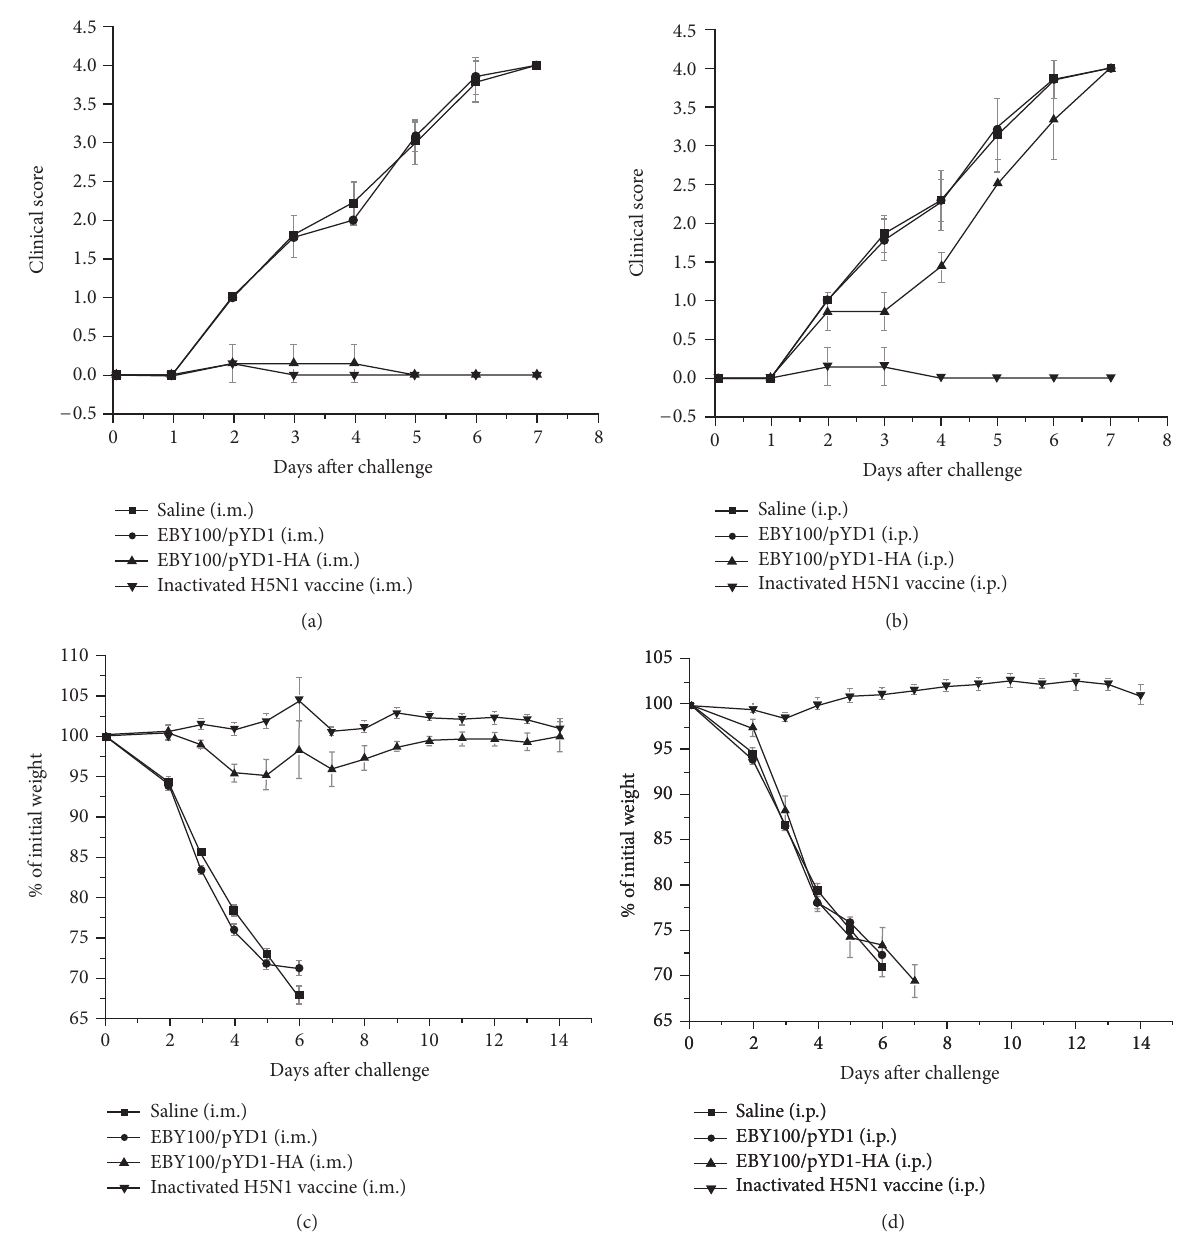
Figure 5: Immune protection conferred by EBY100/pYD1-HA against lethal challenge with homologous H5N1 virus. (a-b) Clinical score on the intramuscularly (i.m.) or intraperitoneally (i.p.) vaccinated mice at 7 days after challenge and (c-d) weight change as a percentage on the intramuscularly (i.m.) or intraperitoneally (i.p.) vaccinated mice after